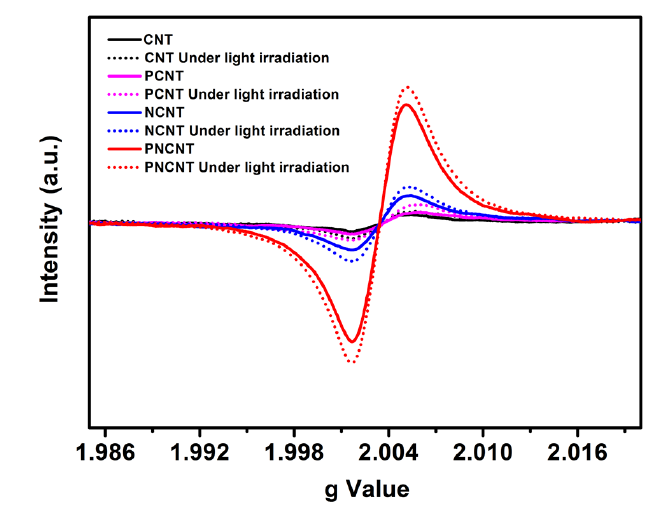
Figure 9. EPR pattern in dark and light irradiation conditions of CNT, NCNT, PCNT and PNCNT samples.